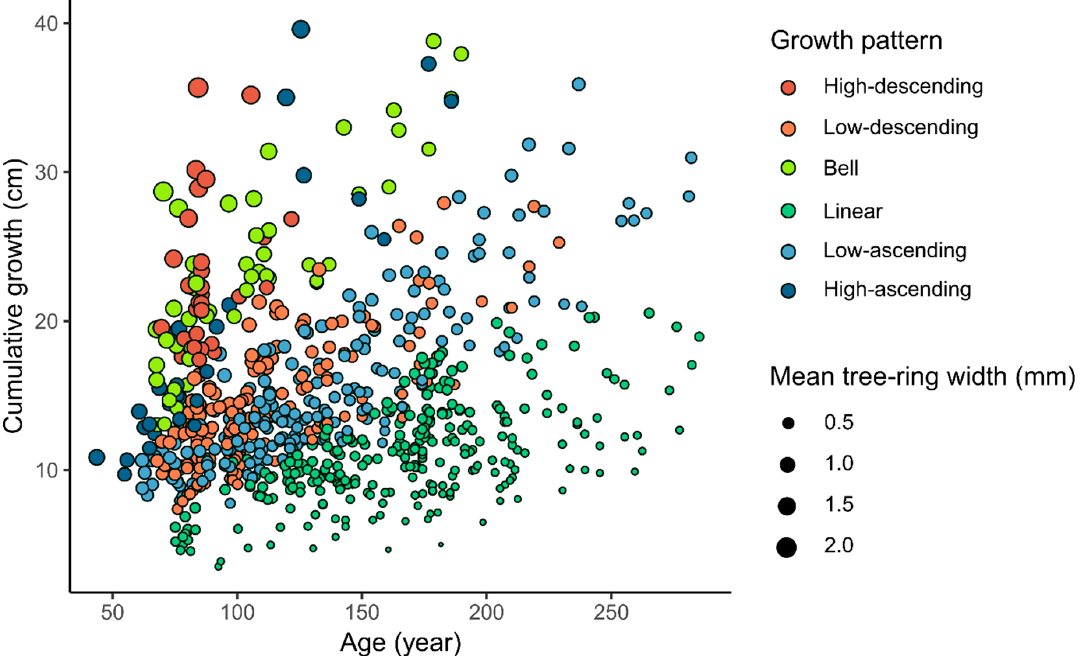
Figure 3. Scatterplot of the studied trees based on their age, cumulative growth, growth pattern, and mean tree-ring width.